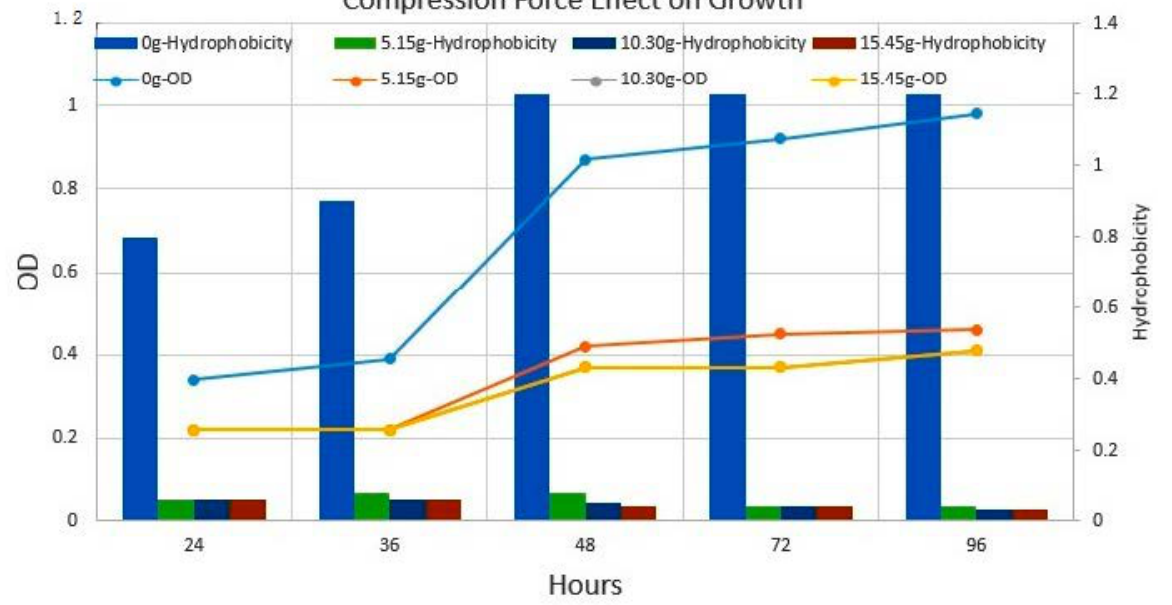
Figure 10. Compression force (weight) effect on growth rate and cell surface hydrophobicity. The bar (secondary Y -axis) in the graph is representing cell surface hydrophobicity. The line (Primary Y -axis) in the graph is representing cell growth at different weight pressures and without weight. The results indicate the application of force resulted in a slowdown of growth rate and